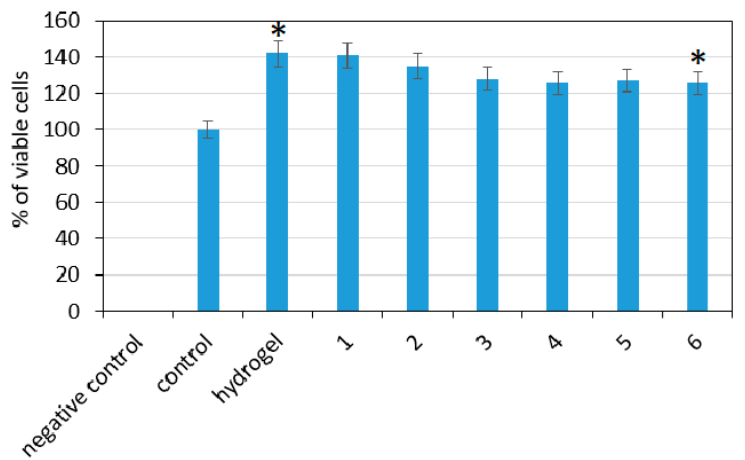
Figure 13. XTT assay carried out on L929 mouse fibroblasts after 48 h: (1) CS-ZnO-1; (2) CS-ZnO-2; (3) CS-ZnO-3; (4) CS-ZnO-4; (5) CS-ZnO-5; and (6) CS-ZnO-6 . (* p < 0.05).